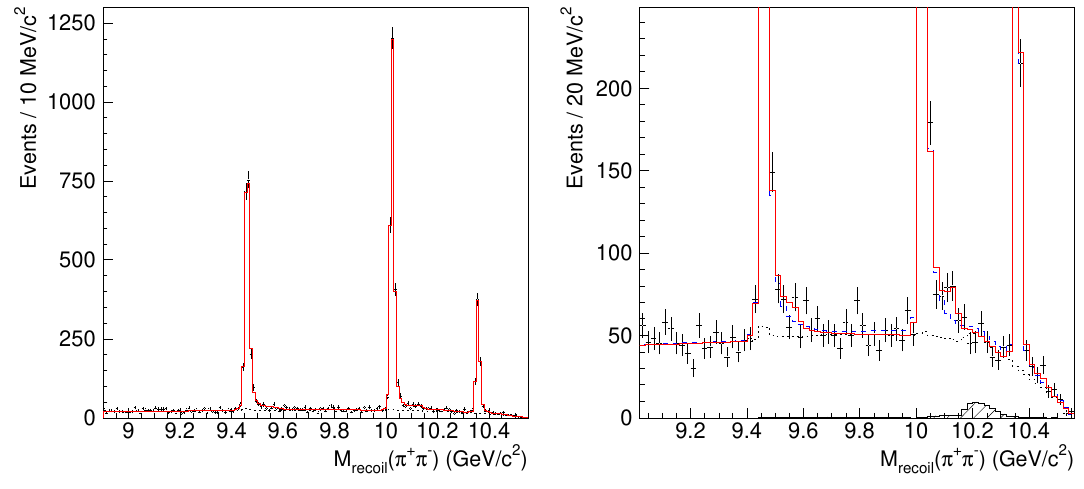
Figure 11 . The M recoil ( (cid:25) + (cid:25) (cid:0) ) distribution for the (cid:22) + (cid:22) (cid:0) (cid:25) + (cid:25) (cid:0) events in the (cid:7)(10860) on-resonance data; the right panel is a zoom of the left panel. Histograms show the results of the simultaneous (cid:12)t to this distribution and the energy dependence of the e + e (cid:0) ! (cid:7)( nS ) (cid:25) + (cid:25) (cid:0) ( n = 1 ; 2 ; 3) cross sections ((cid:12)gure 10). The red solid histogram corresponds to the default (cid:12)t, while the blue dashed histogram in the right panel corresponds to the (cid:12)t with the new structure excluded. The black dotted histogram shows the background component of the default (cid:12)t, the hatched one | peaking background from (cid:17) decays.